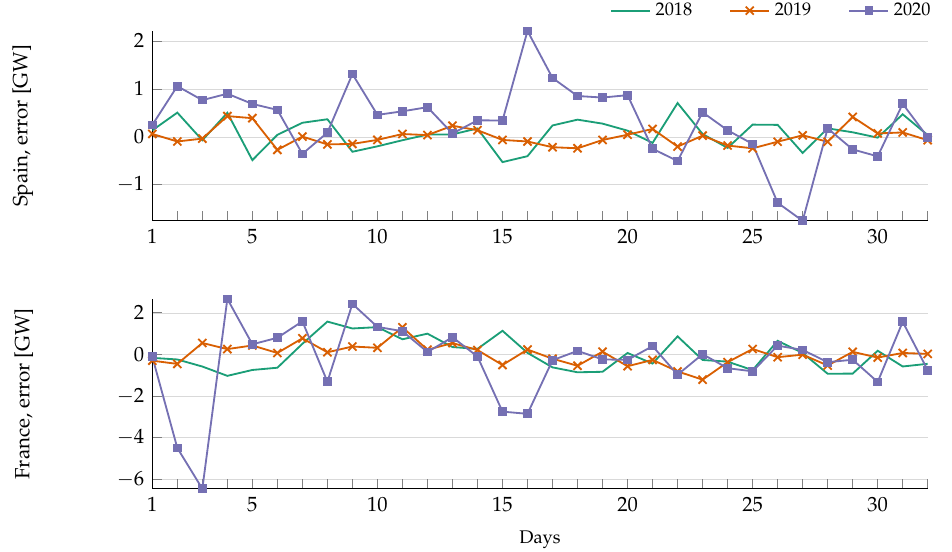
Figure 7. Load forecasting error in Spain and France between 15 March and 15 April in